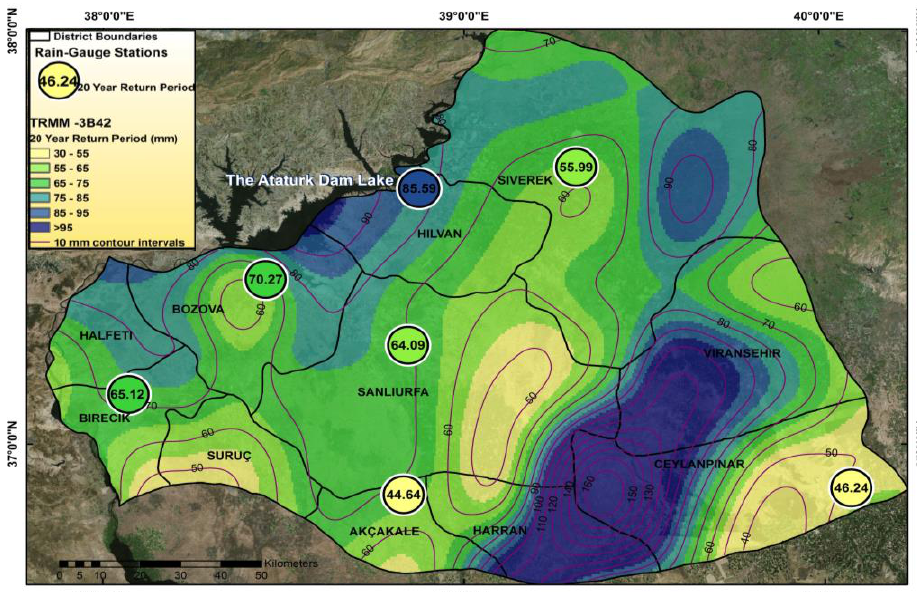
Fig 5. Spatial distribution of extreme events defined by 20-year return values (15-year and 20-year results are similar) of the annual maximum daily rainfall using the GEV distribution. Color background shows results from Inverse Distance Weighted (IDW) and is based on TRMM values. Circles indicate gauge-based recurrence intervals within a 20-year period.